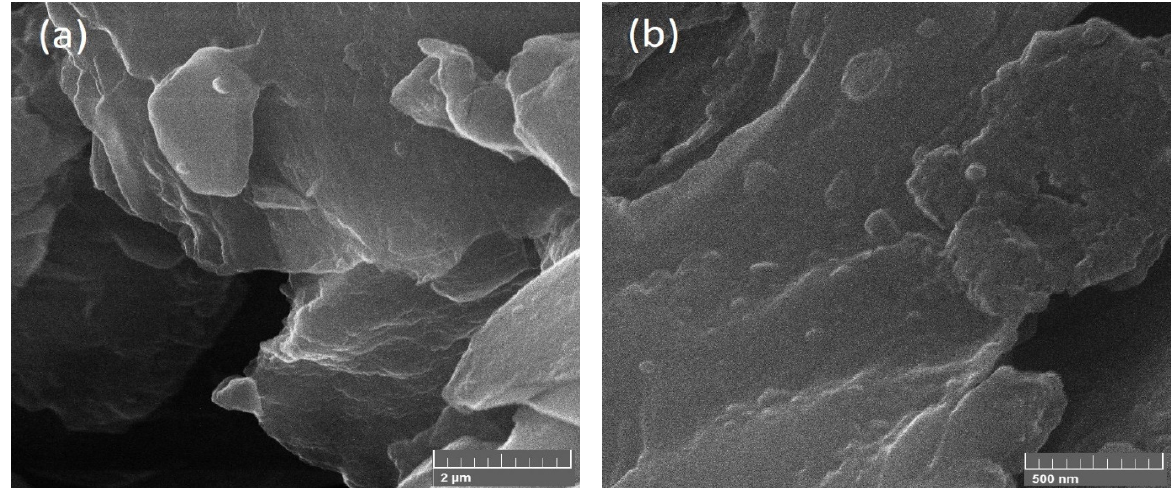
Figure 2. SEM Images of NiFe nanoparticles on ( a ) low and ( b ) high resolution.